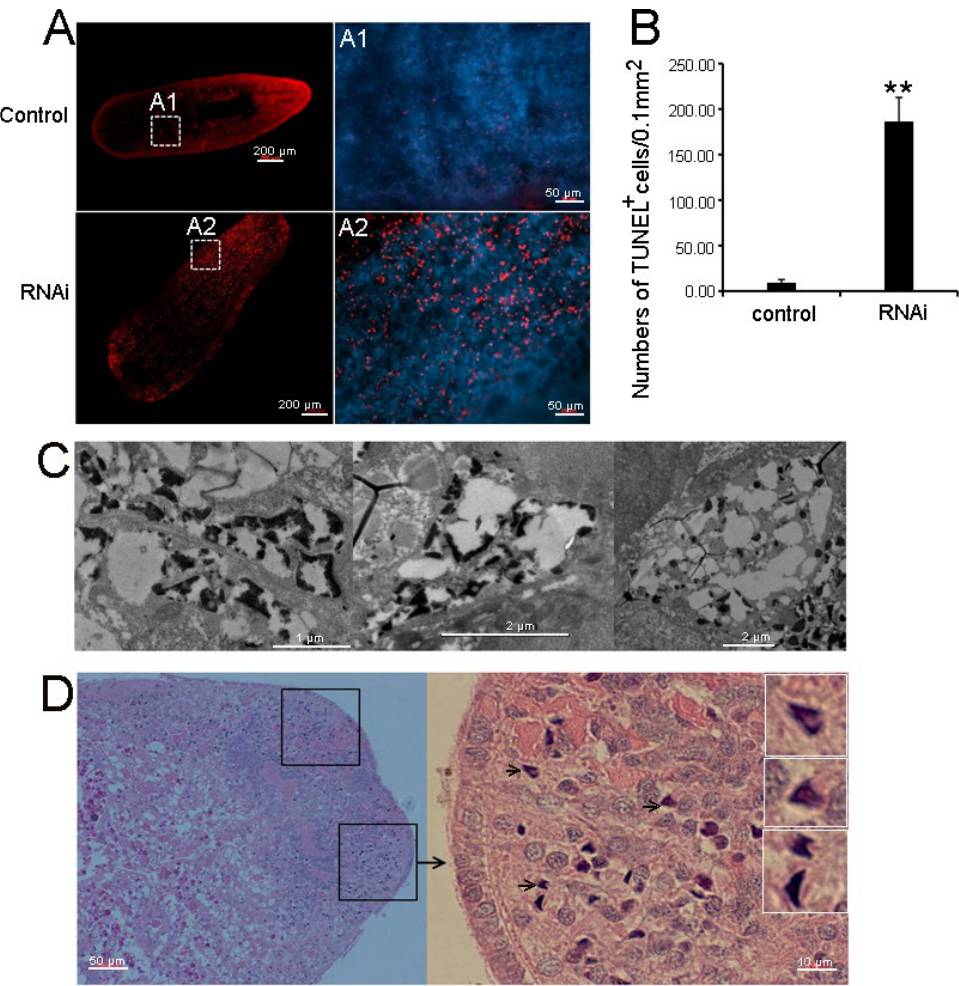
Figure 5. RNAi- Djhsp60 induced cell death in planarians. ( A ) Representative images of TUNEL- stained intact animals. A1 and A2 indicate image magnification. ( B ) Quantification of TUNEL positive cells, n = 5 animals. Asterisks indicate statistical differences (** p < 0.01). ( C ) Necrotic-like cell death in RNAi animals revealed by TEM. ( D ) Necrotic-like cell death in RNAi animals revealed by HE staining. Black box indicates the degenerating tissue. Arrow indicates the dead cell. White boxes indicate the image magnification of the dead cells. RNAi-animals with mild-head defect were collected for HE staining and TEM.